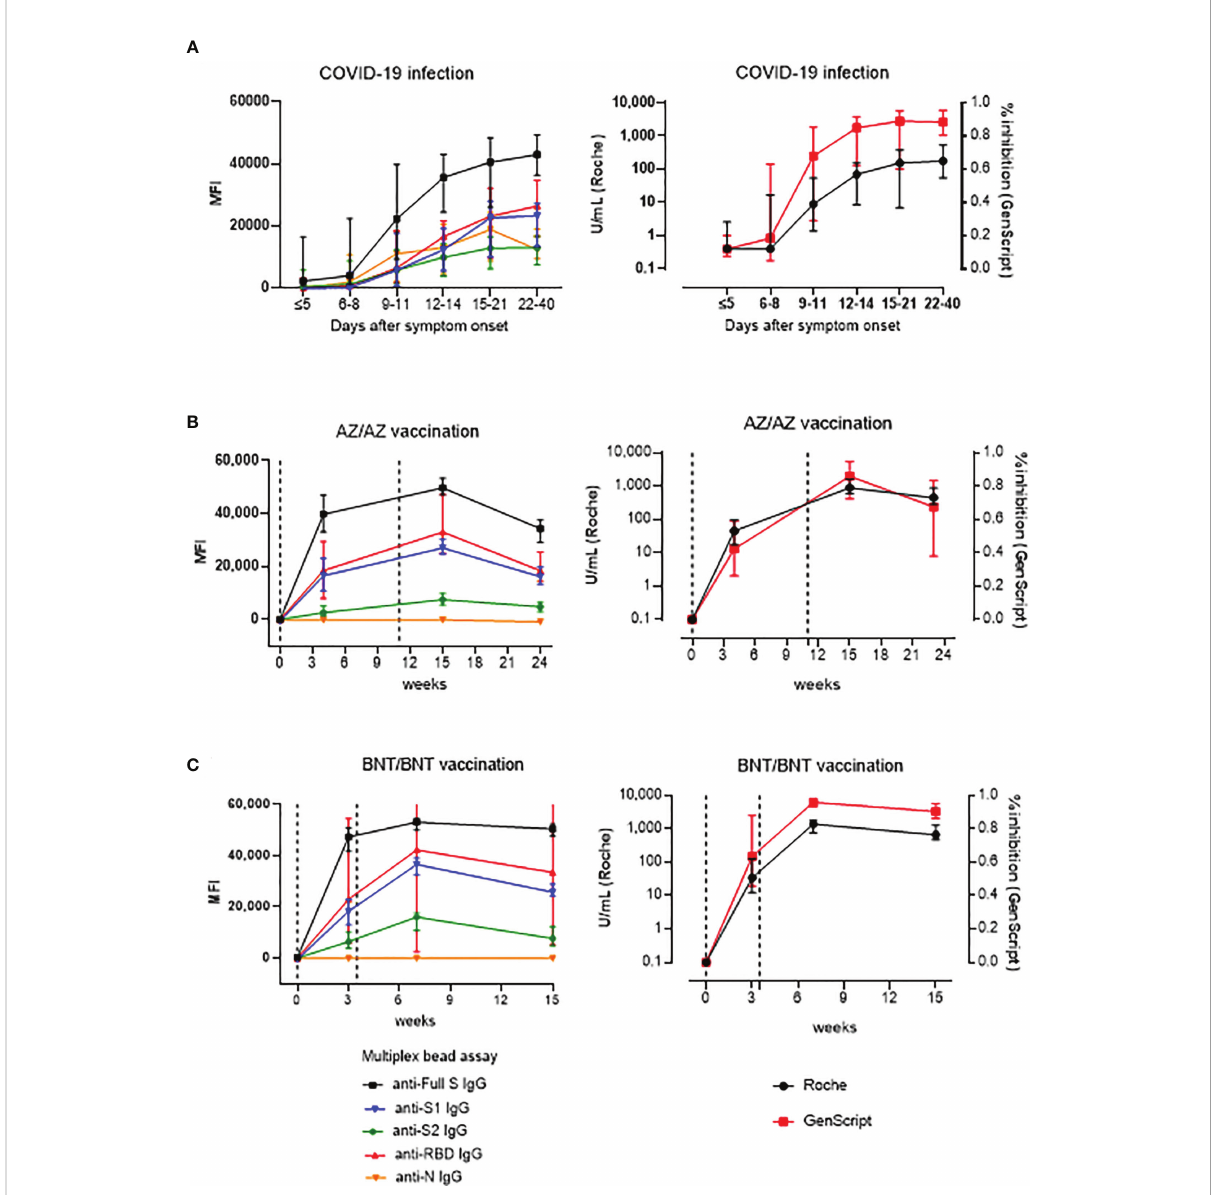
FIGURE 2 Kinetics of antibody response by multiplex (One-lambda), Roche and GenScript assay in naïve COVID-19 infection (n=32) (A) , AZ/AZ vaccination (n=20) (B) and BNT/BNT (n=20) vaccination (C) . X-axis shows the time point presented in days after symptom onset (A) and in weeks after the 1st-dose vaccination (B, C) . The 1st- and 2nd-dose vaccination time points are indicated by dotted lines. Data are presented as median and